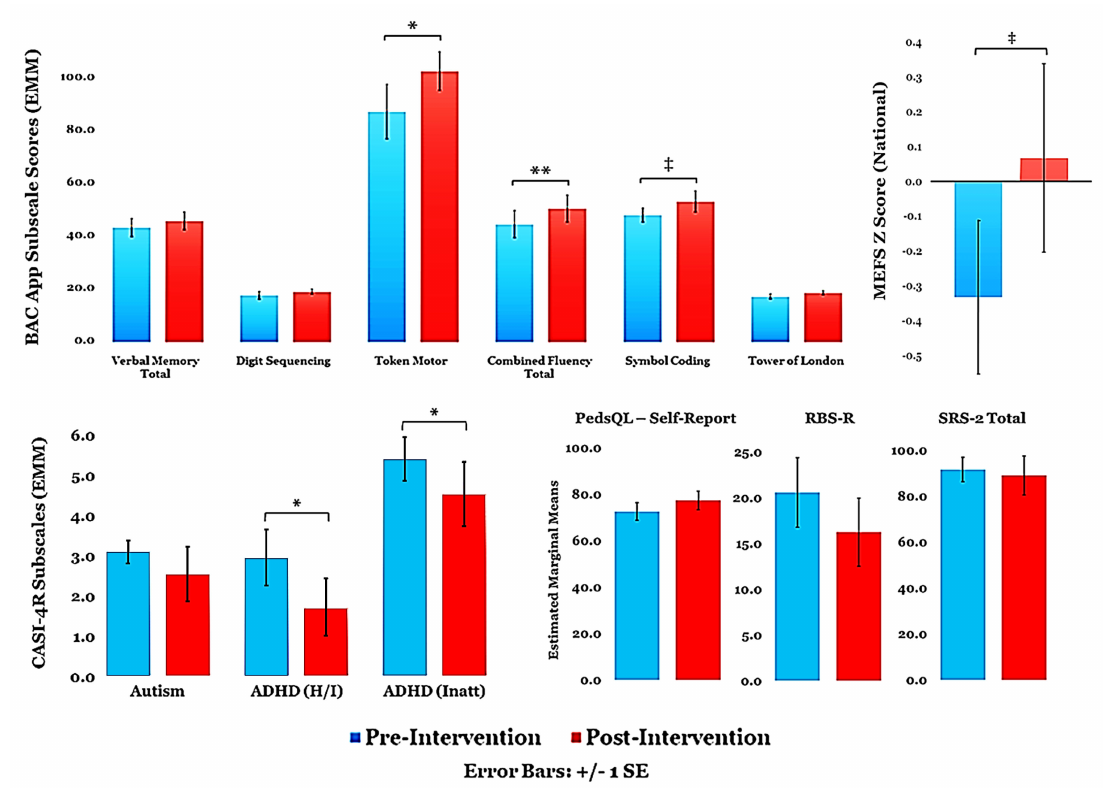
Figure 2. Mean pre-/post-intervention scores on clinical and cognitive assessments. Covariates appearing in the model are evaluated at the following values: Age = 17.04, Sex = 0.17. ** p < 0.01; * p < 0.05; ‡ p < 0.10